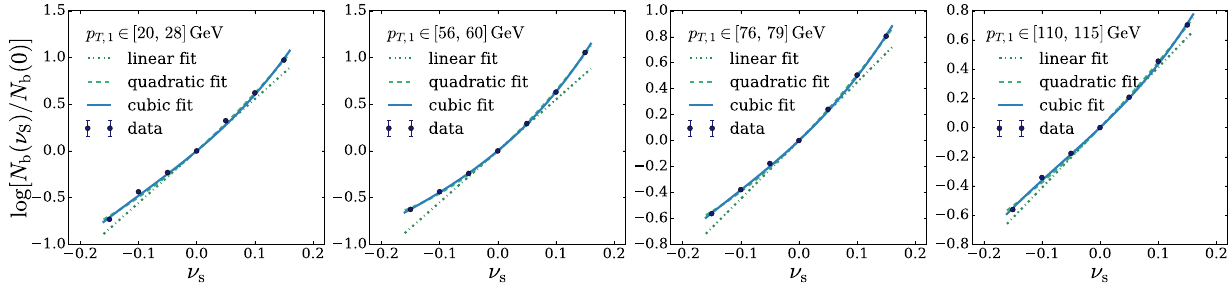
Fig. 18 Same as Fig. 17, but for M 12 > 120 GeV (lower